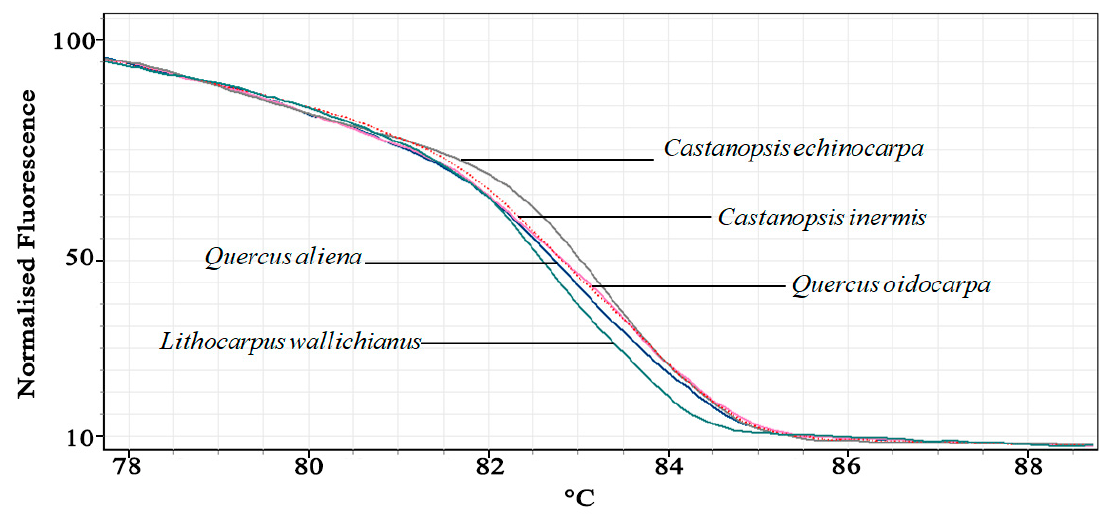
Figure 2. Melting profiles of five Fagaceae species generated from HRM analysis using M1 primers. Table 4. Details of the candidate primers from manual design and web-based tools.